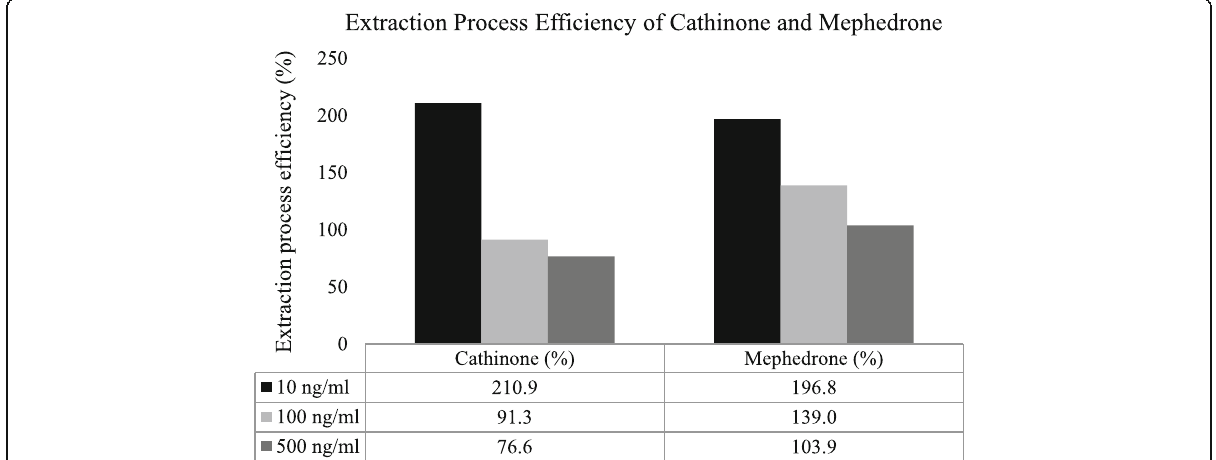
Fig. 1 Extraction process efficiency of cathinone and mephedrone by solid phase extraction using Strata X Drug B cartridge and Shimadzu LC-MS/MS 8030